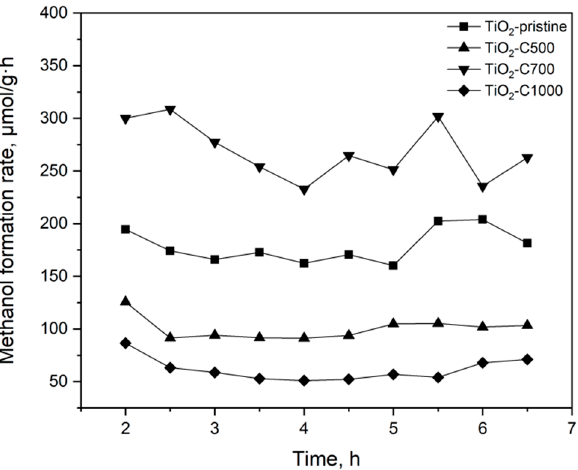
Figure 7. The photocatalytic activity of TiO 2 samples under UV–VIS irradiation as a function of reaction time on stream at 100 °C.